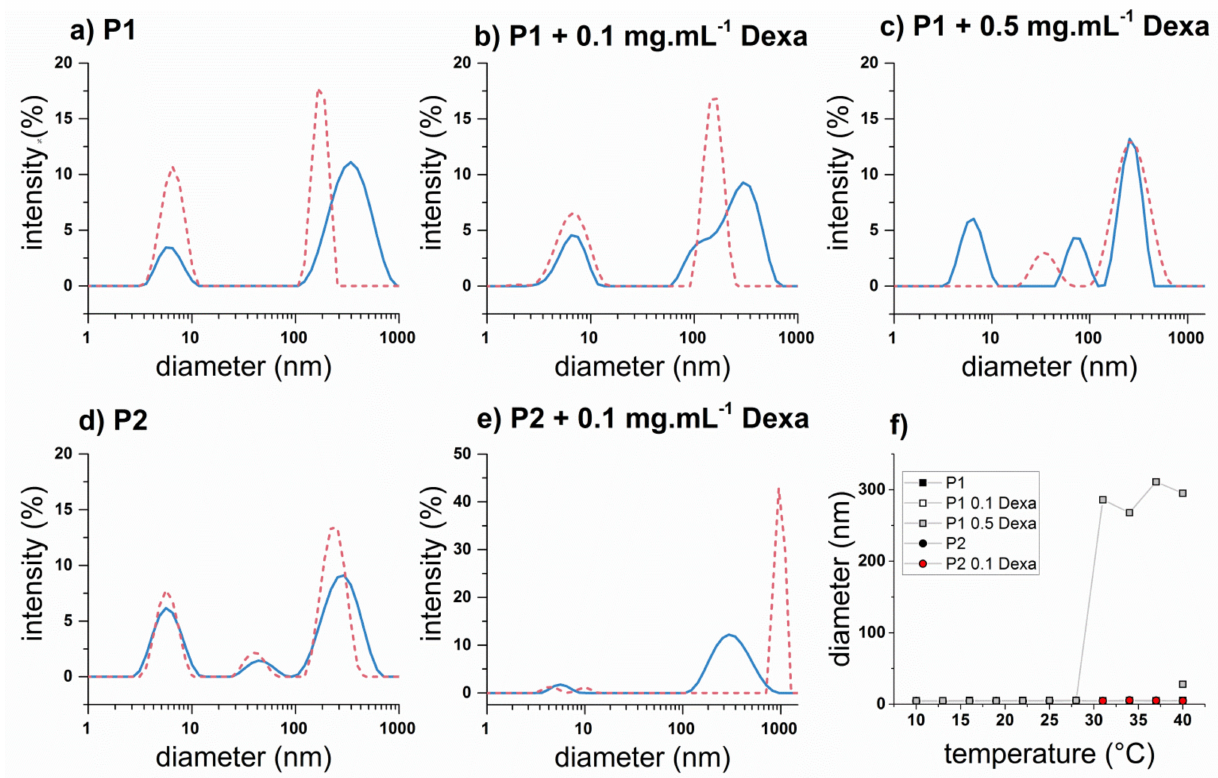
Figure 3. Thermoresponsive behavior of P1 and P2 copolymers (10 mg · mL − 1 in PBS) with various concentrations of Dexa (0, 0.1, and 0.5 mg · mL − 1 ) measured by DLS. Plots ( a – e ) represent intensity-weighted size distributions of cold (10 ◦ C, blue solid line) and hot (40 ◦ C, red dashed line) copolymer solutions, plot ( f ) represents D h from volume-weighted size distribution as a function of temperature for all